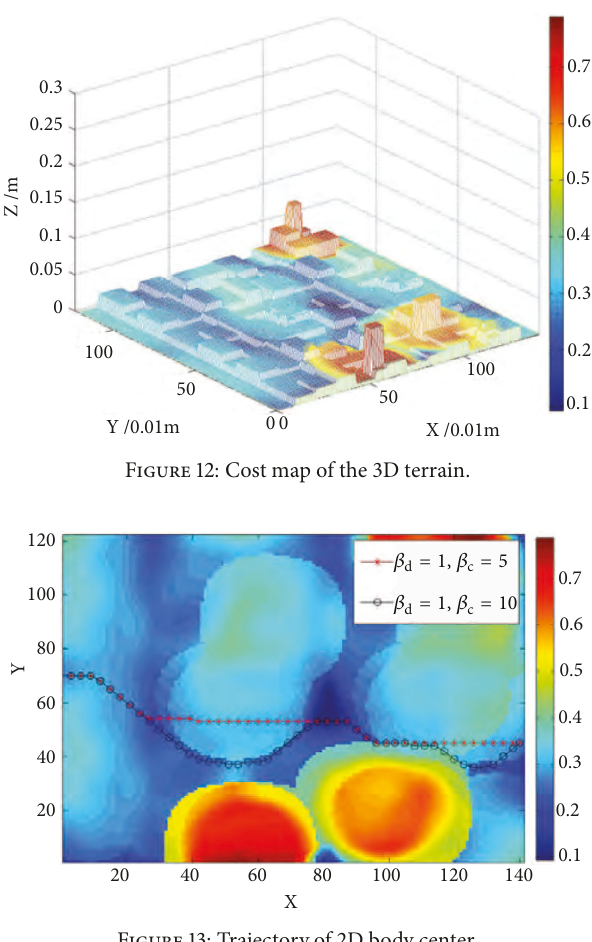
Figure 13: Trajectory of 2D body center.